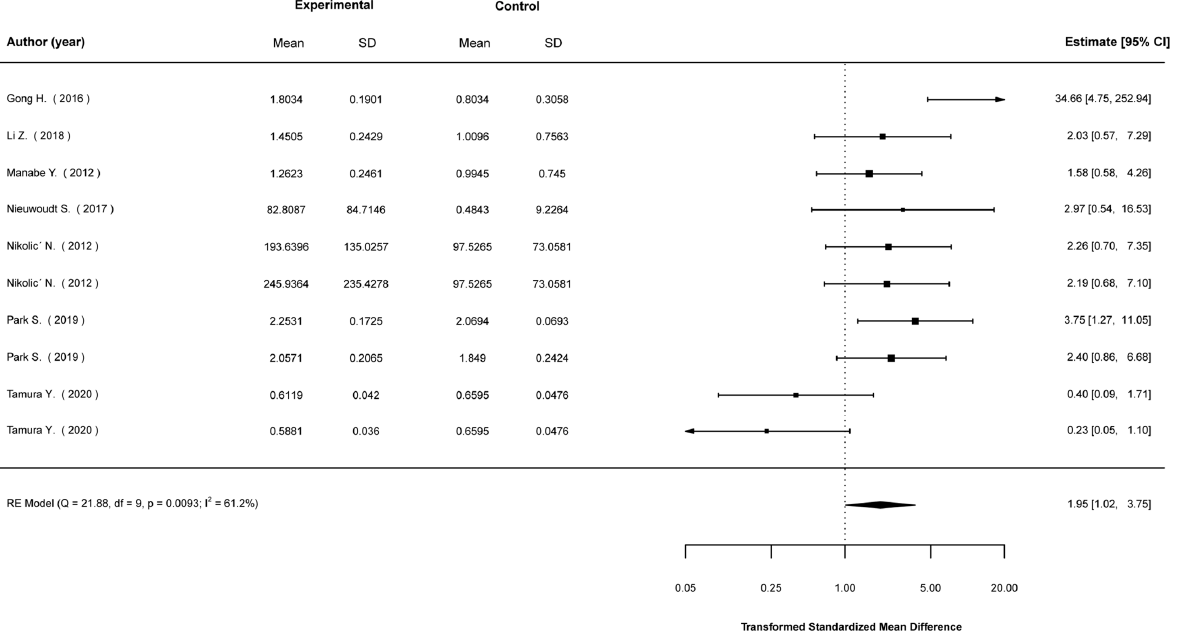
Figure 6. Findings of random-effects meta-analysis on the effects of EPS on glucose uptake compared to non-stimulated cells. Results shown are transformed standardized mean differences and 95% confidence intervals, as an estimate of the log odds ratio. Differences greater than 1.00 favour the EPS cells compared to non-stimulated control cells [21,28,29,31,45,48,53].